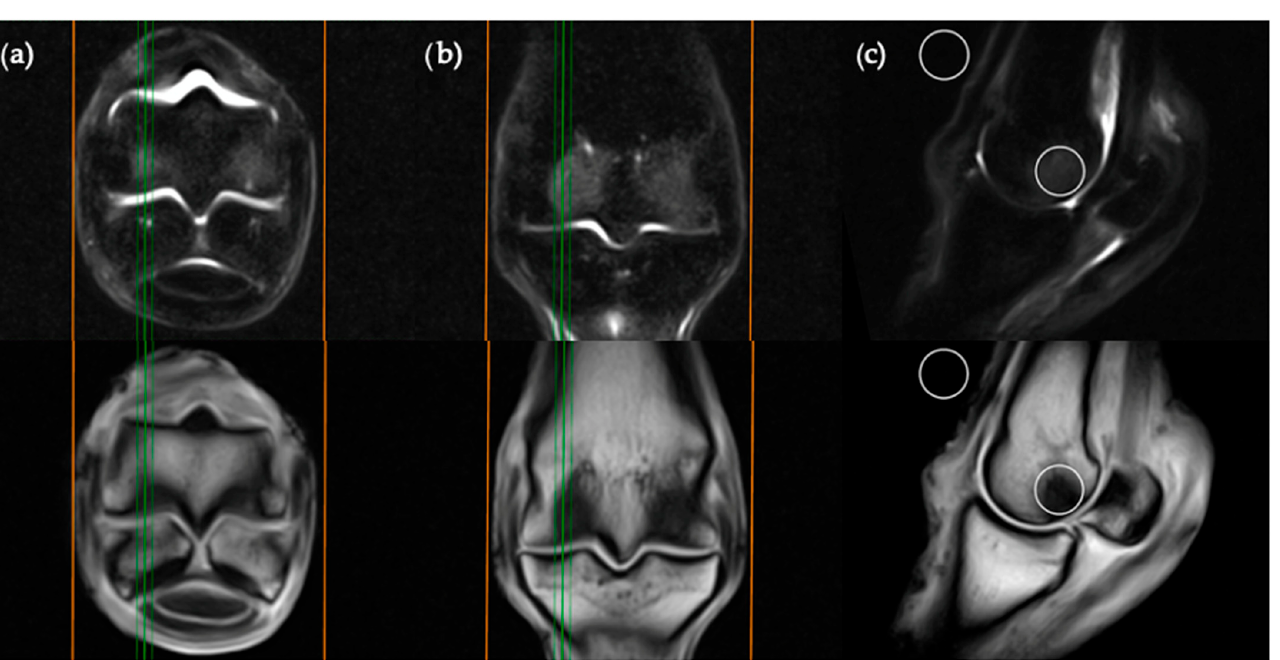
Figure 2. STIR FSE (top row) and T1W GRE (bottom row) MRI images in ( a ) transverse; ( b ) frontal and ( c ) sagittal planes; demonstrating the location of ROI placements in a transverse plane. The green lines on the frontal and sagittal images show the standardized orientation and location of the transverse slice for ROI placement. The orange lines show the extent and orientation of all the transverse slices acquired in the MRI study.